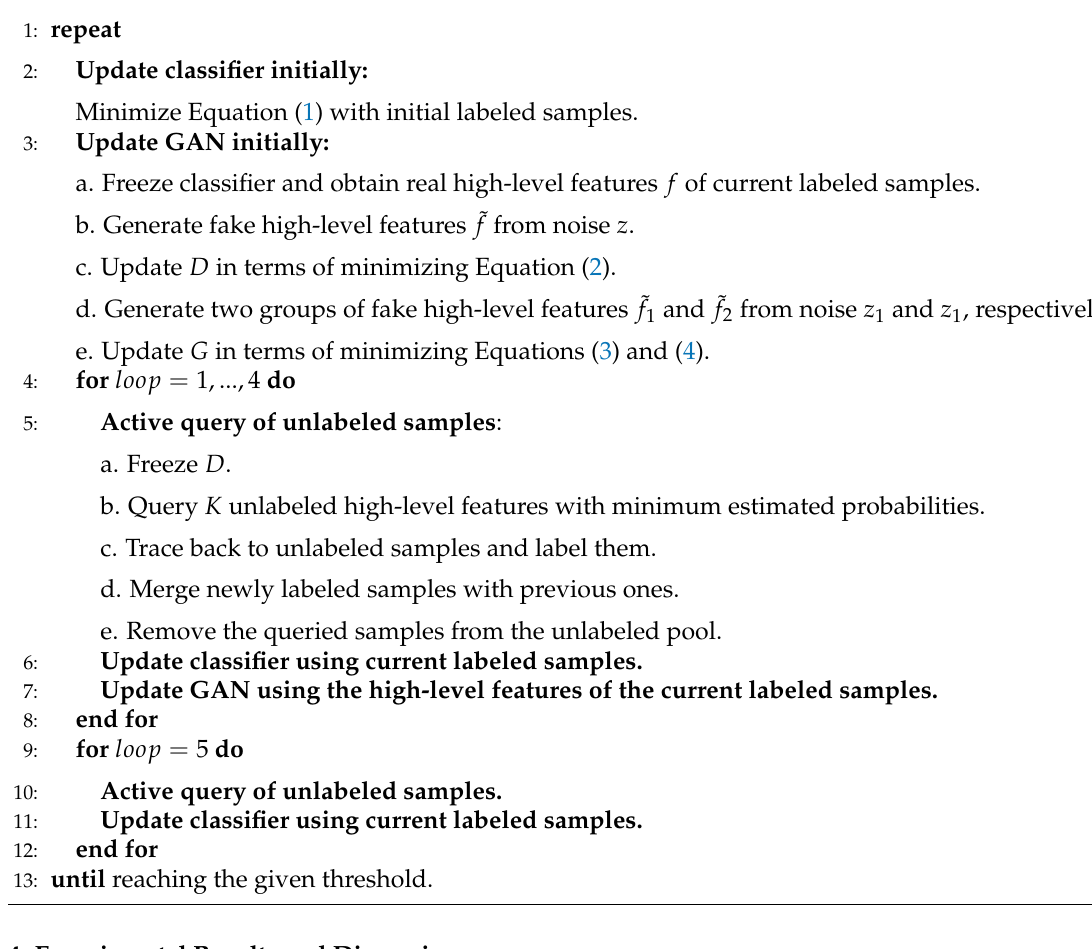
Algorithm 1 Feature-oriented adversarial active